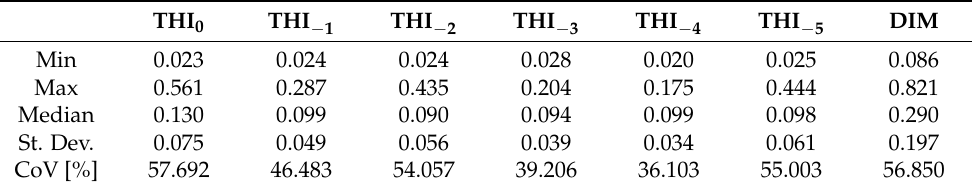
Table 1. Minimum value, maximum value, median value, standard deviation value, and coefficient of variation (CoV) value of the ISs obtained for the different independent variables calculated for the whole dataset in scenario